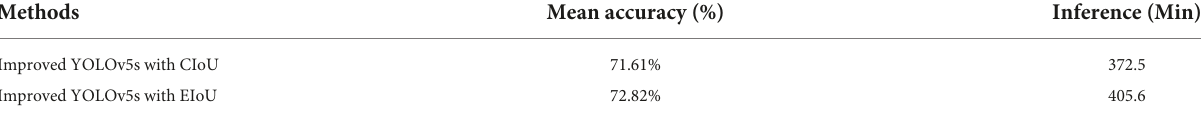
TABLE 5 Comparison of average accuracy and training time between CloU and EloU of YOLOv5 models.